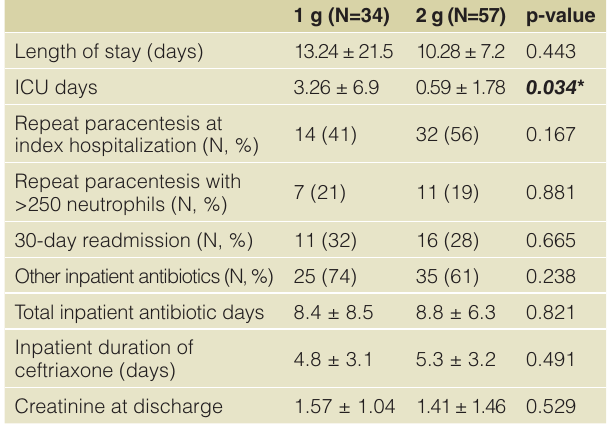
Table 2. Hospital course characteristics by ceftriaxone